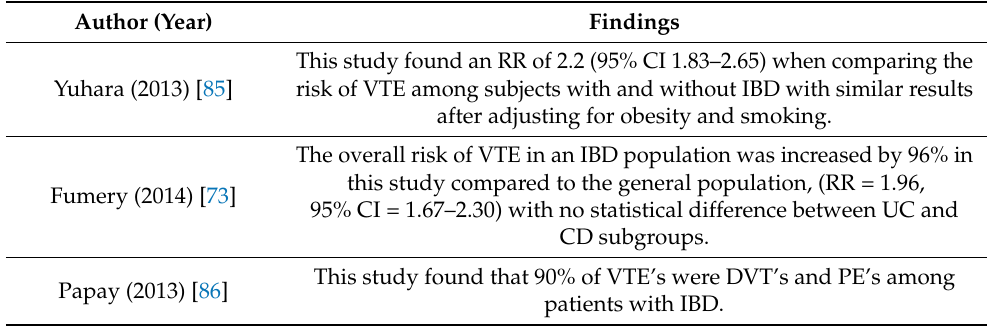
Table 1. Summary of studies reporting the risk of VTE in patients with